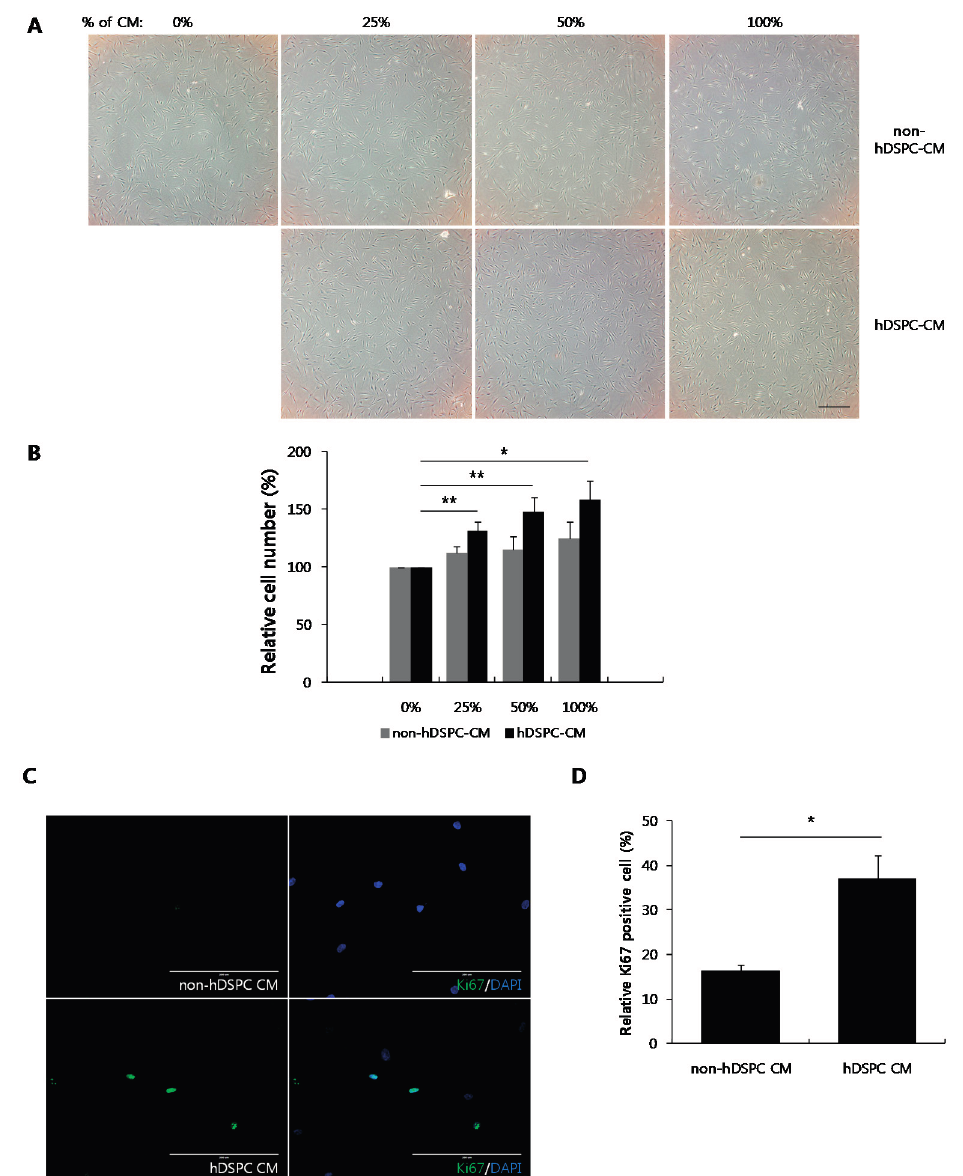
Figure 1. hDSPC-CM promoted proliferation in senescent fibroblasts. Senescent fibroblasts were treated with the indicated concentrations of either non-hDSPC-CM ( upper panel) or hDSPC-CM ( lower panel). Images were taken 24 h after CM treatment. The scale bar represents 500 μ m ( A ); Senescent fibroblasts were incubated with the indicated concentrations of each CM for 24 h and cell-counting assays were performed. Graphs depict the means ± S.E.M of three independent experiments. * p < 0.05, ** p < 0.01 ( B ); Senescent fibroblasts were treated with 50% of either non-hDSPC-CM or hDSPC-CM for 24 h. Immunofluorescent staining assays were performed with anti-Ki67 (green) antibody and DAPI (blue). The scale bar represents 400 μ m ( upper panel) or 200 μ m ( lower panel) ( C ); Ki67-positive cells were quantified. The graph depicts means ± S.E.M from three independent experiments. * p < 0.05 ( D ). Data were statistically compared with the unpaired Student’s t -test ( B , D